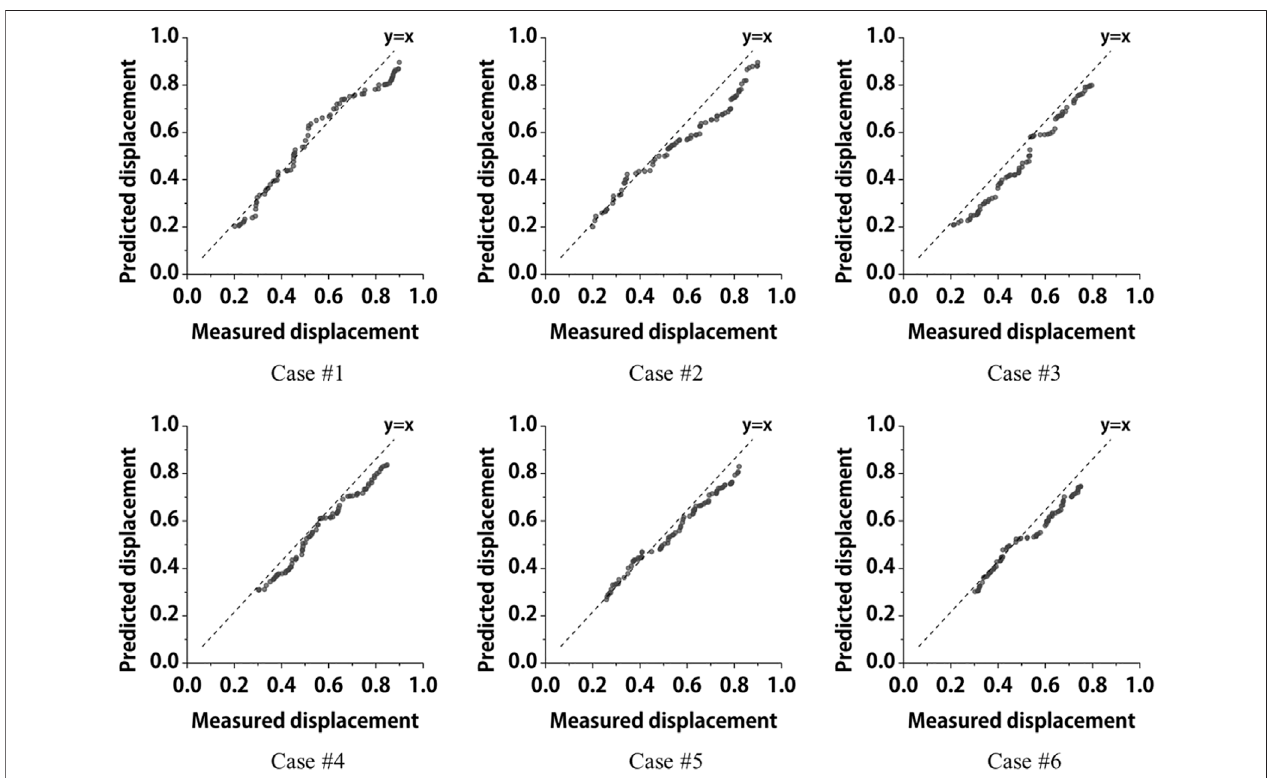
FIGURE 4 | Actual measured displacement versus the predicted displacement.